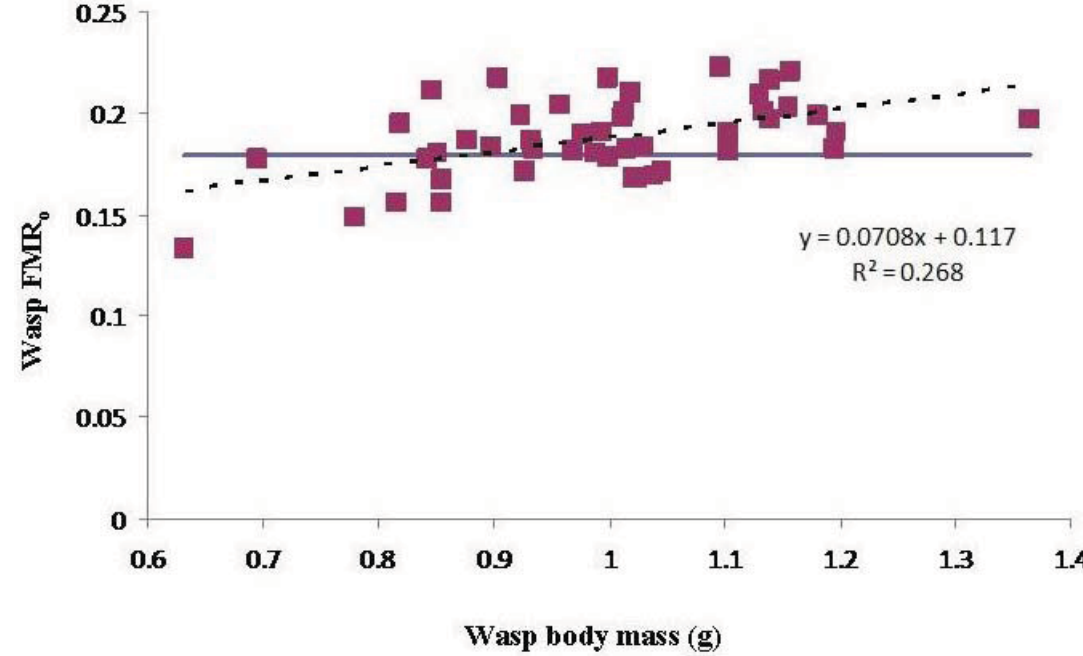
Figure 2. The effect of wasp body mass on operational flight muscle ratio. The slope of the regression line (dashed) is significant (P < 0.01). The blue line indicates the marginal flight muscle